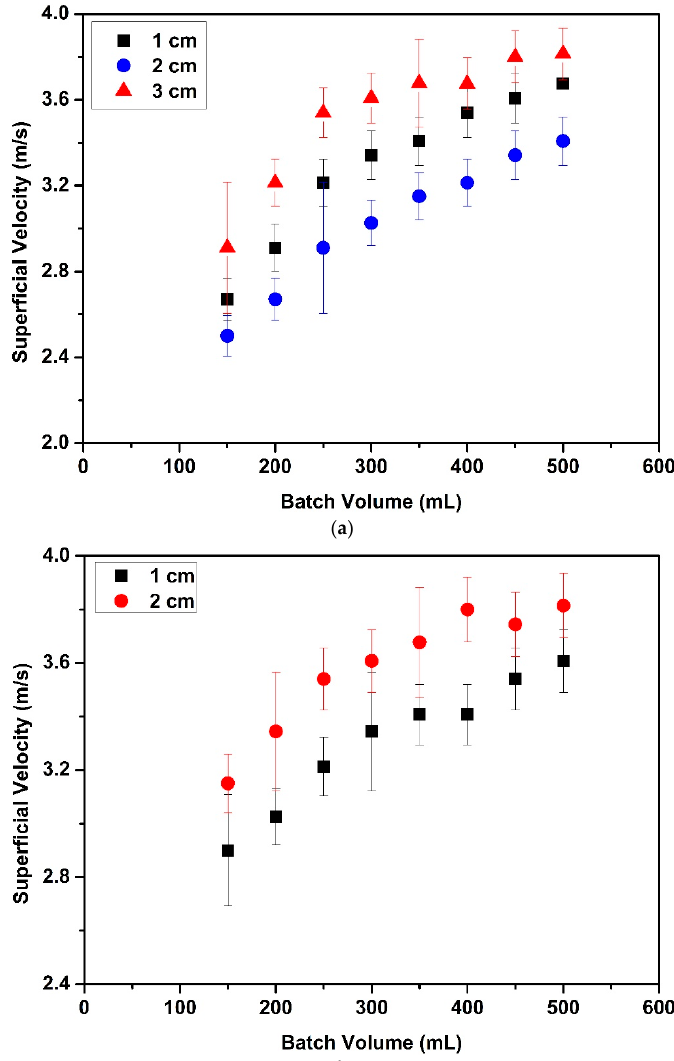
Figure 4. Superficial velocities at onset of circulatory motion in the bed for different batch volumes and partition gap heights: ( a ) The wide Wurster tube (diameter: 10 cm); ( b ) the narrow Wurster tube (diameter: 8 cm).